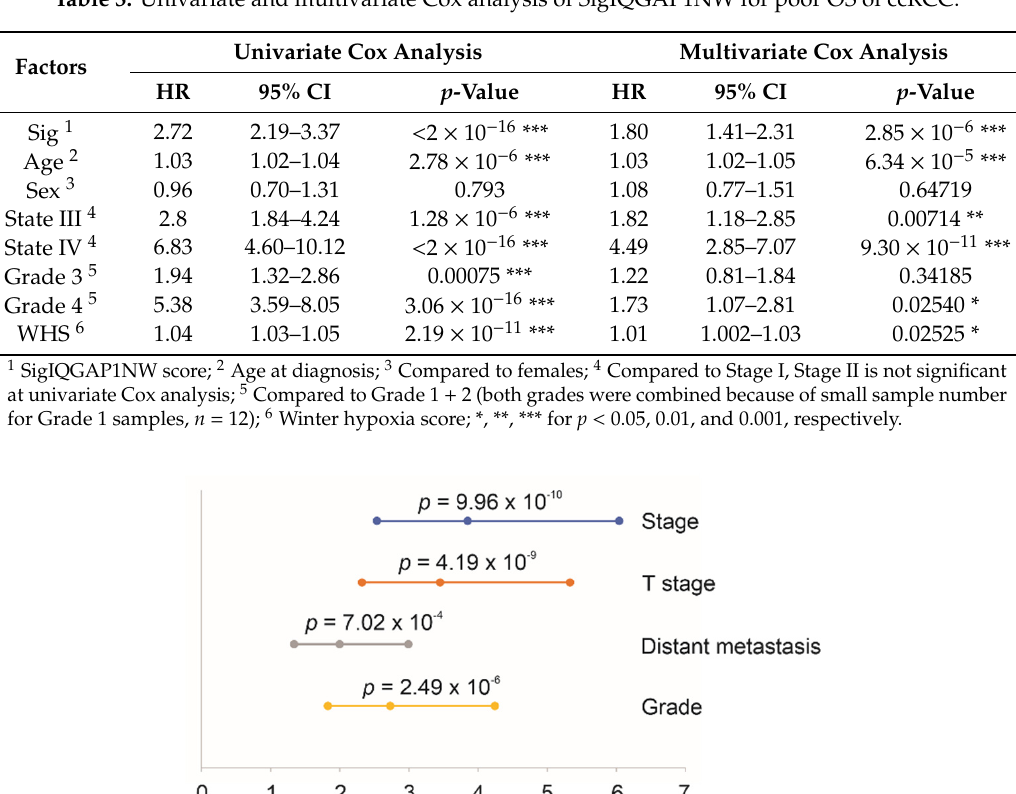
Table 3. Univariate and multivariate Cox analysis of SigIQGAP1NW for poor OS of ccRCC.